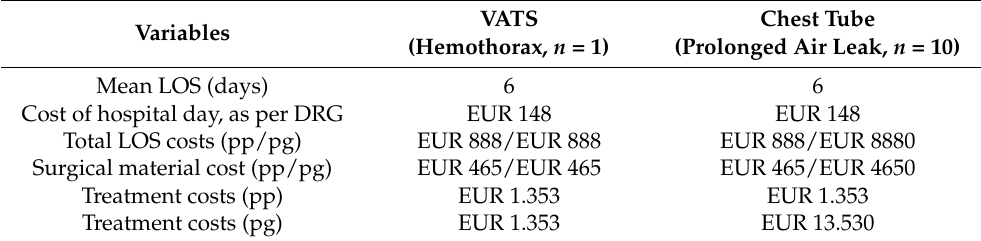
Table 5. Complication management costs (secondary VATS).